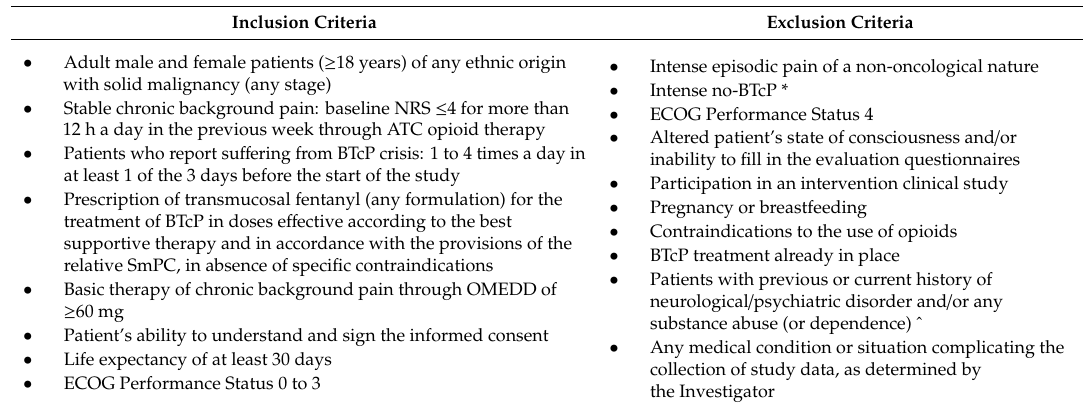
Figure 3. Breakthrough cancer pain (BTcP) results . ( A ) Features, ( B ) trend, and ( C ) response to therapy. Table 1. Inclusion and exclusion